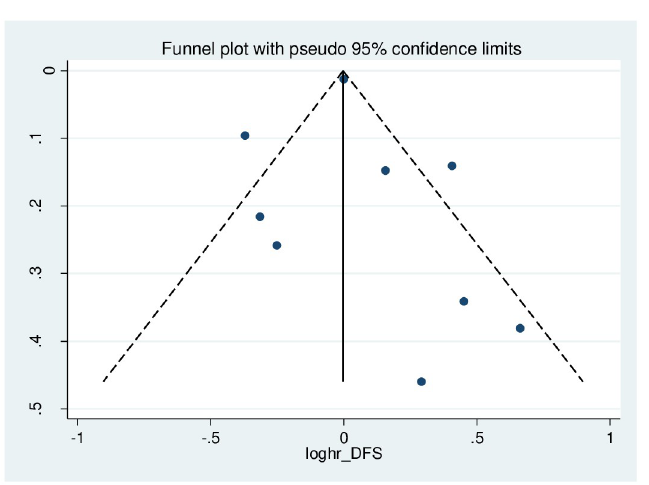
Fig 5. The funnel plot for publication bias evaluation.